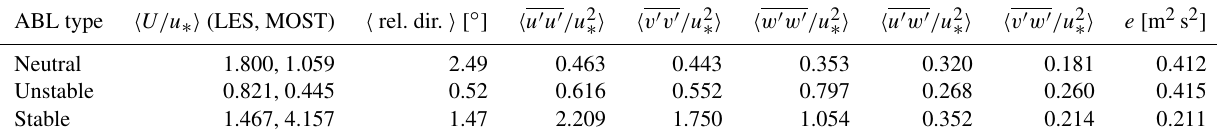
Table 2. RMSEs of the normalized simulated wind speeds, turning of the wind (rel. dir.), normalized turbulent fluxes, and the total TKE e for each of the ABL types. For the normalized wind speed, we show both the values for the LES and for the MOST profiles.